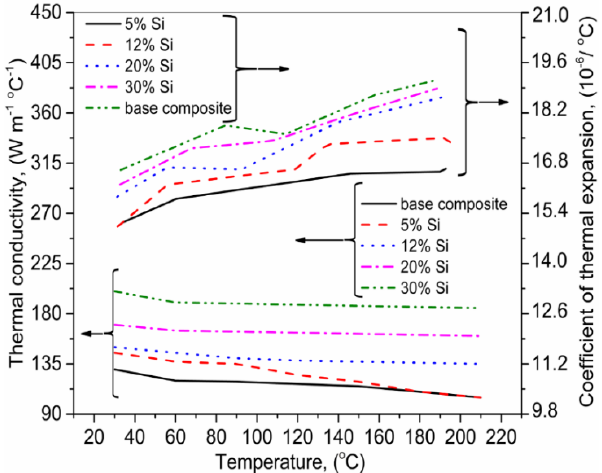
Figure 14. The relation between temperature and various fractions of Si on thermal conductivity and thermal expansion coefficient; based on the data provided in Ref.